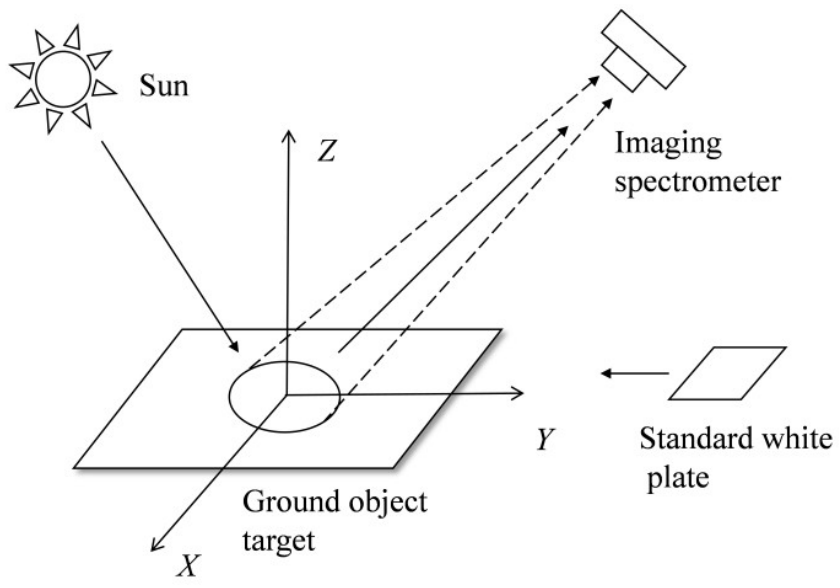
Figure 1. Acquisition of target spectral reflectance by field measurement.